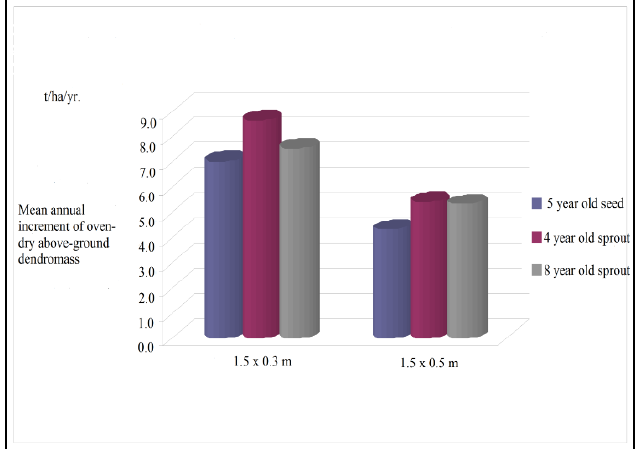
Figure 2. Above-ground dendromass is the function of the planting spacing and the age of the sprouted black locust stand-parts (Helvécia (80A)